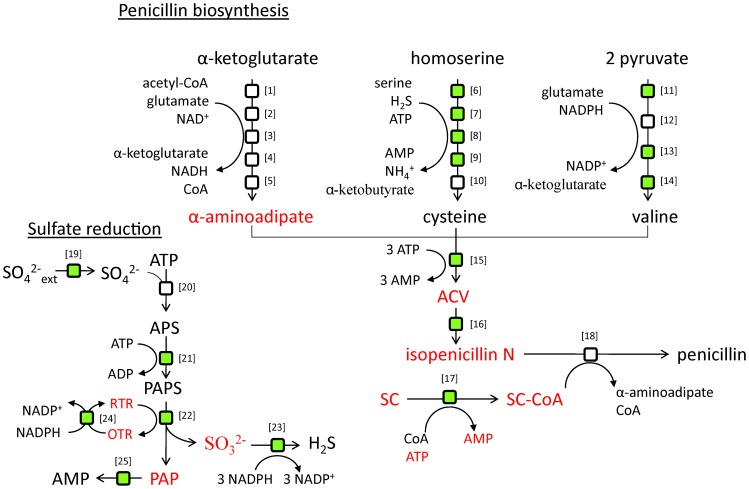
Integrative analysis of a high and a low producing strain.Depicts synthesis pathways of penicillin and important precursors. Green boxes correspond to reactions identified as being transcriptionally controlled and up-regulated by the algorithm (see text). Metabolites around which significant transcriptional changes occur compared to a low producing strain are colored red. SC: side chain (e. g. the precursor molecule phenylacetic acid). The biosynthesis of penicillin starts with the condensation of the three amino acids α-aminoadipate (an intermediate in the L-lysine biosynthesis pathway), L-cystein, and L-valine to form the tripeptide ACV. ACV is further converted to isopenicillin N. For the industrially relevant types of penicillin a side-chain is supplied to the media. This side-chain is activated by ligation to coenzyme A. In the last step of penicillin biosynthesis an acyl transferase exchanges the α-aminoadipate moiety of isopenicillin N with the side-chain, thereby generating penicillin and regenerating α-aminoadipate. Since L-cystein is a sulfur-containing amino acid penicillin production is also tightly associated with sulfur metabolism. The corresponding model IDs for the enzymes are indicated within parentheses. [1] homocitrate synthase (r0683); [2] homocitrate dehydrase (r0684); [3] homoaconitate hydrase (r0685); [4] homoisocitrate dehydrogenase (r0688); [5] α-aminoadipate aminotransferase (r0689); [6] homoserine transacetylase (r0600); [7] O-acetylhomoserine sulfhydrylase (r0601); [8] cystathione-β-synthase (r0632); [9] cystathione-γ-lyase (r0606); [10] acetate CoA ligase (r0025); [11] acetolactate synthase (r0465); [12] ketol-acid reductoisomerase (r0653); [13] dihydroxy acid dehydrase (r0656); [14] branched chain amino acid transferase (r0648); [15] ACV synthase (r0814); [16] isopenicillin N synthase (r0812); [17] acyl CoA ligase (side chain dependent, reaction is for phenylacetate CoA ligase) (r0747); [18] isopenicillin N N-acyltransferase (r0813); [19] sulfate permease (r1408); [20] sulfate adenyl transferase (r1151); [21] adenyl sulfate kinase (r1147); [22] phosphoadenyl sulfate reductase (r1148); [23] sulfite reductase (r1149); [24] thioredoxin reductase (r0419); [25] 3′(2′),5′-bisphosphate nucleotidase (r1150).